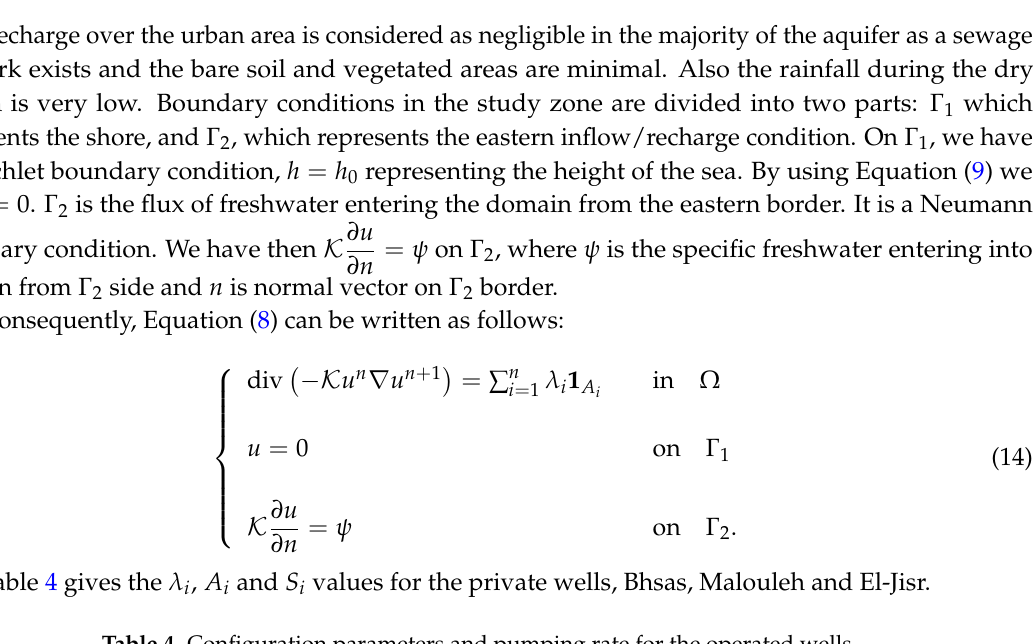
Figure 7. Mesh discretization of the domain.